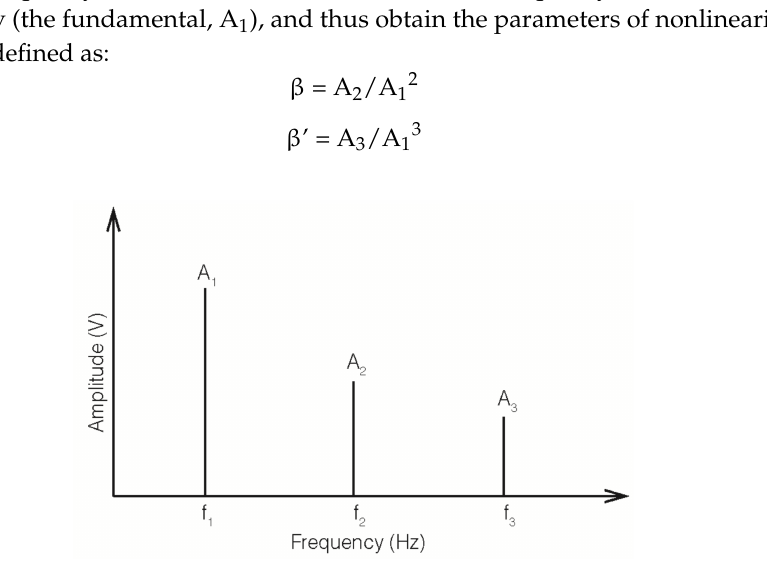
Figure 4. Frequency spectrum showing the emitted frequency (f 1 ), and two of the generated harmonics (f 2 and f 3